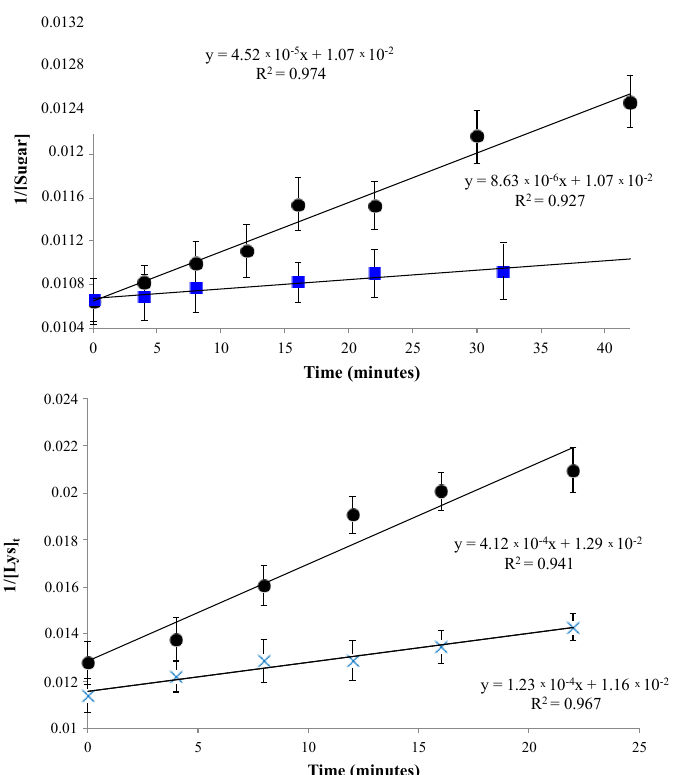
Figure 6. The kinetic plots of the second-order thin film Maillard reaction for the ( a ) L-glycine/sugar systems and ( b ) L-lysine/sugar systems.